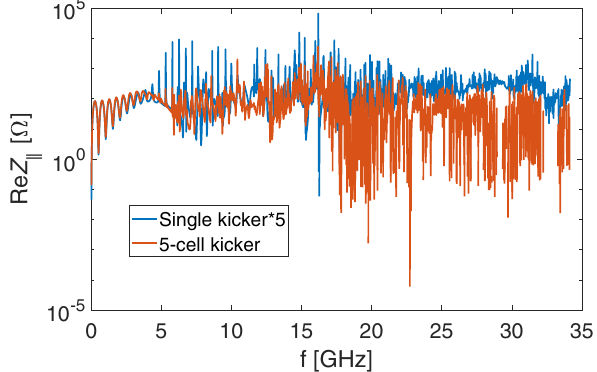
FIG. 2. The real part of the longitudinal beam coupling impedance of the five-cell stripline kicker, which is compared with that of the single cell kicker multiplied by a factor of 5.